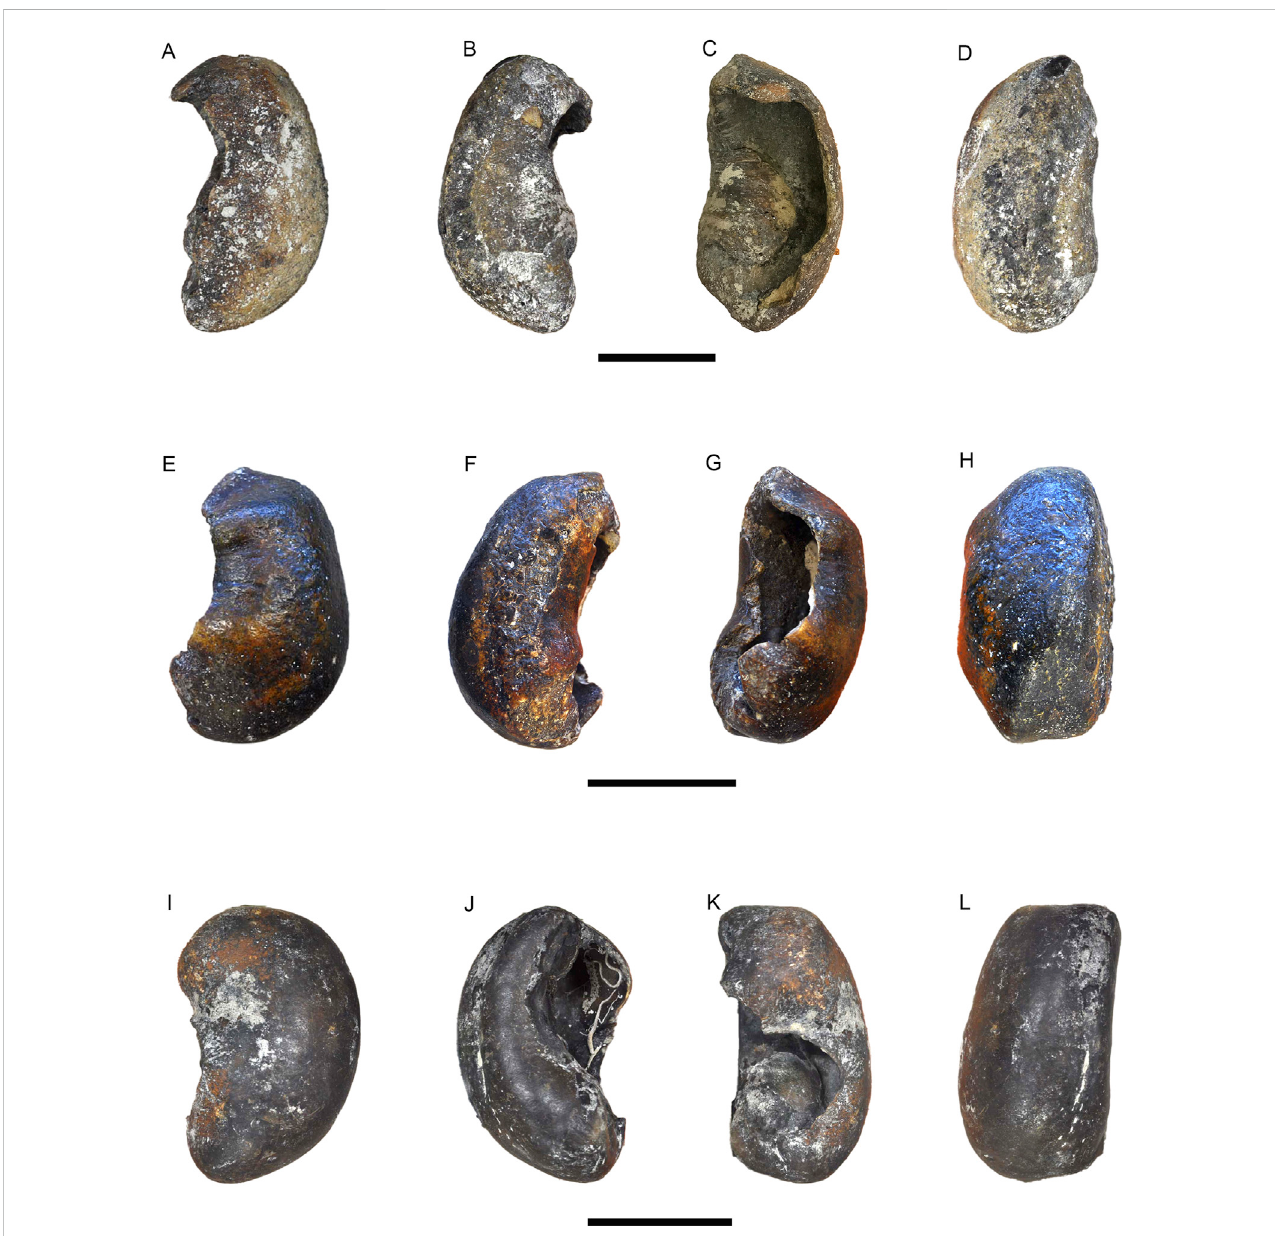
FIGURE 8 Balaenopteraindet.,SAM-PQ-3088, (A) ventral, (B) dorsal, (C) lateral,and (D) medialview,scale=5 cm.SAM-PQ-3093in (E) ventral, (F) dorsal, (G) lateral, and (H) medial view, scale=5 cm. Caperea sp., SAM-PQ-3090 in (I) ventral, (J) dorsal, (K) lateral, and (L) medial view, scale=5